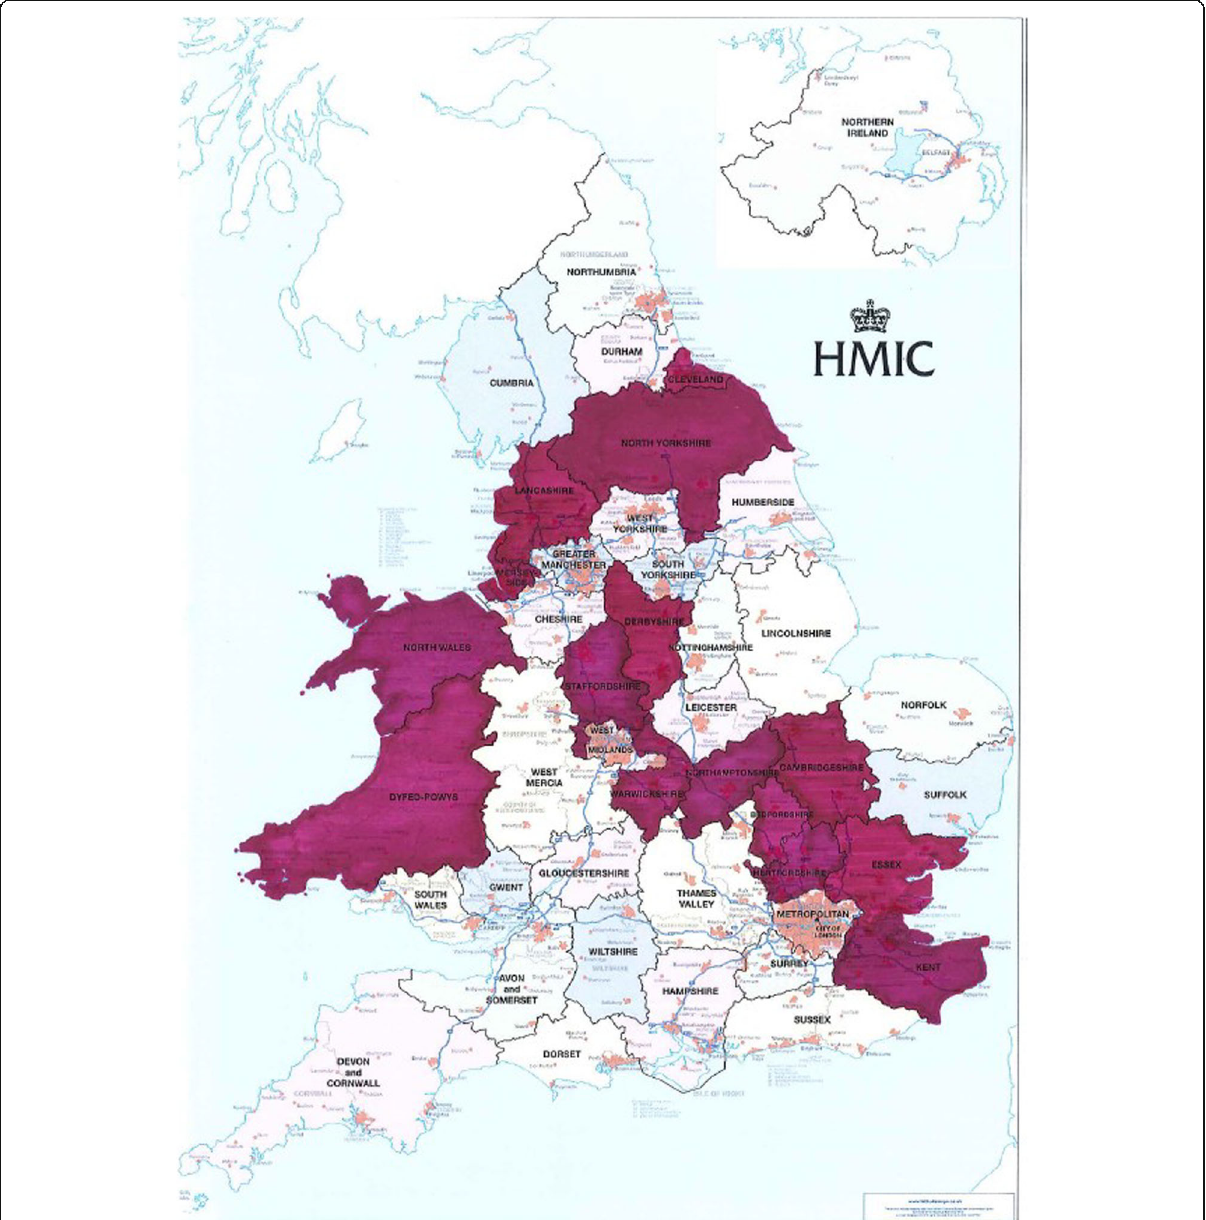
Fig. 1 Map to show the 15 police service regions represented by the participants who completed the questionnaire (highlighted in purple). Adapted from original by